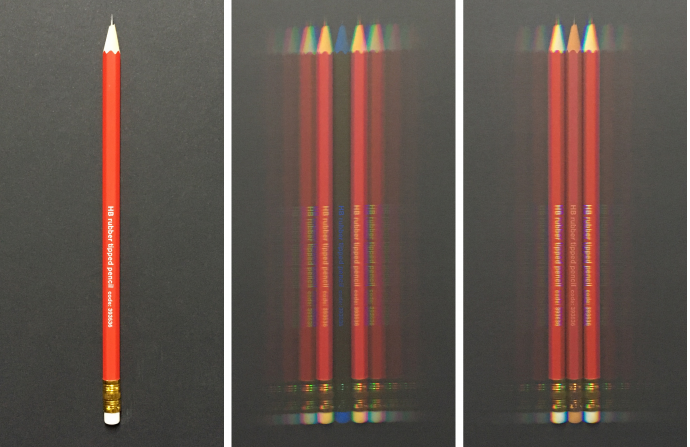
Figure 8. Images of a red pencil ( left ) through the grating with suppressed zero order ( middle ) and the three splitter ( right